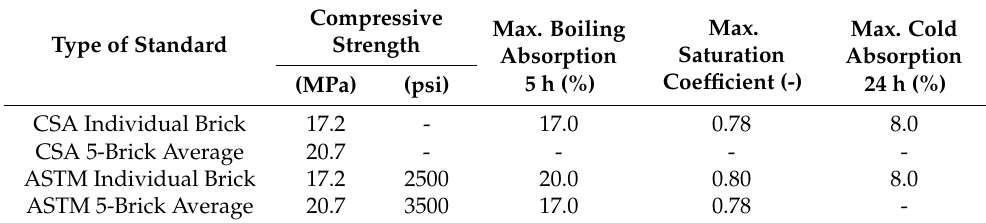
Table 1. Requirements for frost-resistant bricks.